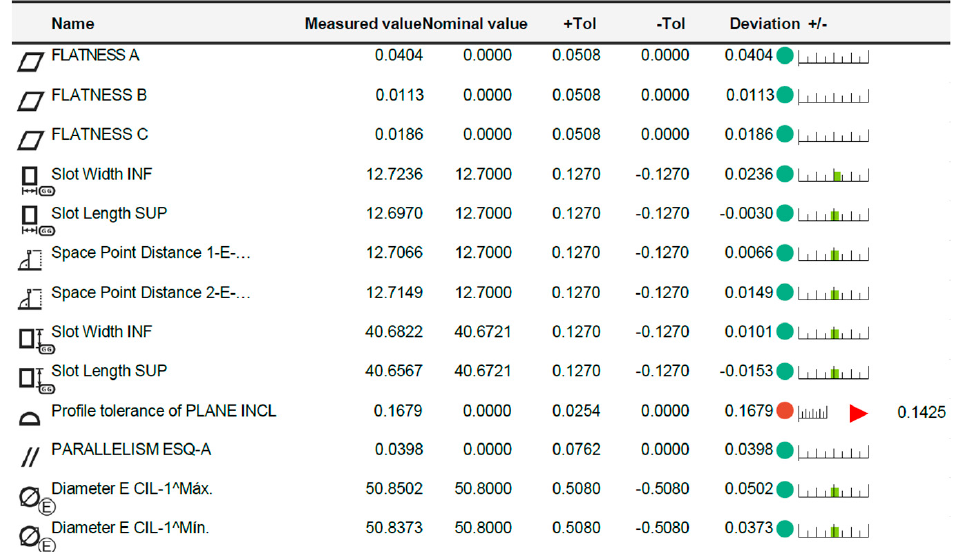
Figure 8. Task-specific uncertainty assessment based on the ZEISS CMM measurement and the ZEISS Figure 8. Task ‐ specific uncertainty assessment based on the ZEISS CMM measurement and the VCMM™ simulation. Example of measurement report including the VCMM ZEISS VCMM™ simulation. Example of measurement report including the VCMM outputs.